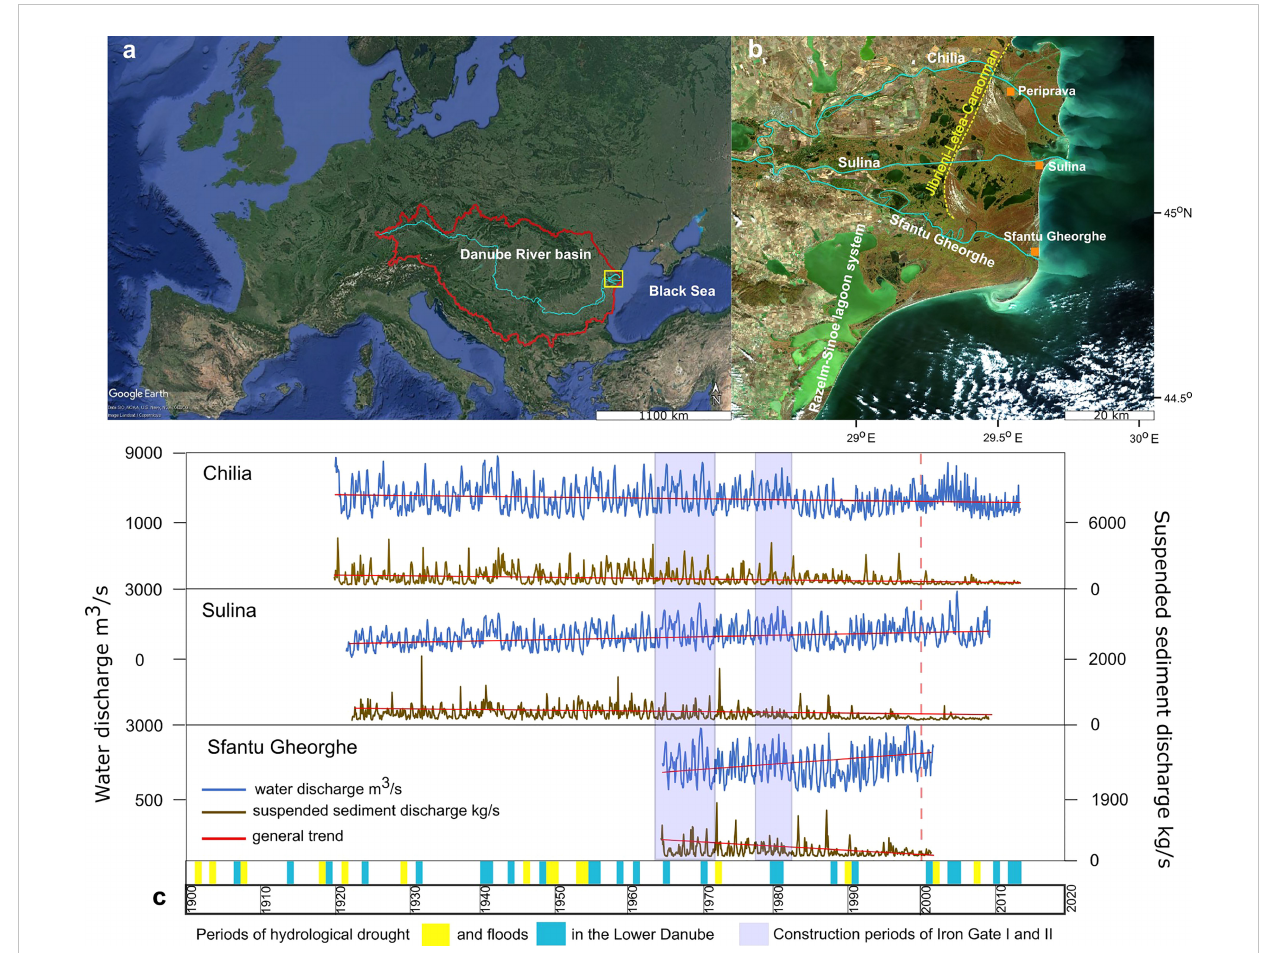
FIGURE 1 (A) Location of Danube Basin in Europe and of Danube Delta (Source image: Google Earth). (B) Danube Delta, with its three discharging arms, and locations of Periprava village, port of Sulina and Sfantu Gheorghe village (RGB image - mosaic of 4 Sentinel 2 images). (C) Monthly averages of water (blue line) and suspended sediment (brown line) discharge and general trend (red line) on Chilia Branch at Periprava (1965-2002) (GeoEcoMar; unpublished data), in port of Sulina (1921-2010) (Constantinescu; 2020); and at Sfantu Gheorghe village (1965-2002) (Tiron, 2010). The blue and yellow squares mark periods of major fl oods (1907, 1914, 1919, 1924, 1932, 1940-1941, 1944, 1947, 1954-1956, 1958, 1962, 1965, 1970, 1975, 1980- 1981, 1988, 1991, 2002, 2005-2006, 2010, 2013-2014) and hydrological drought (1902, 1904, 1908, 1918, 1921, 1929, 1946, 1949-1950,